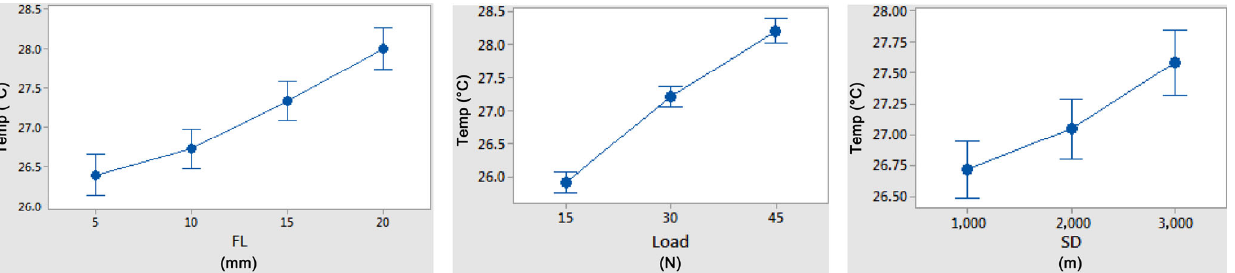
Fig. 5 Main effects plot for interfacial